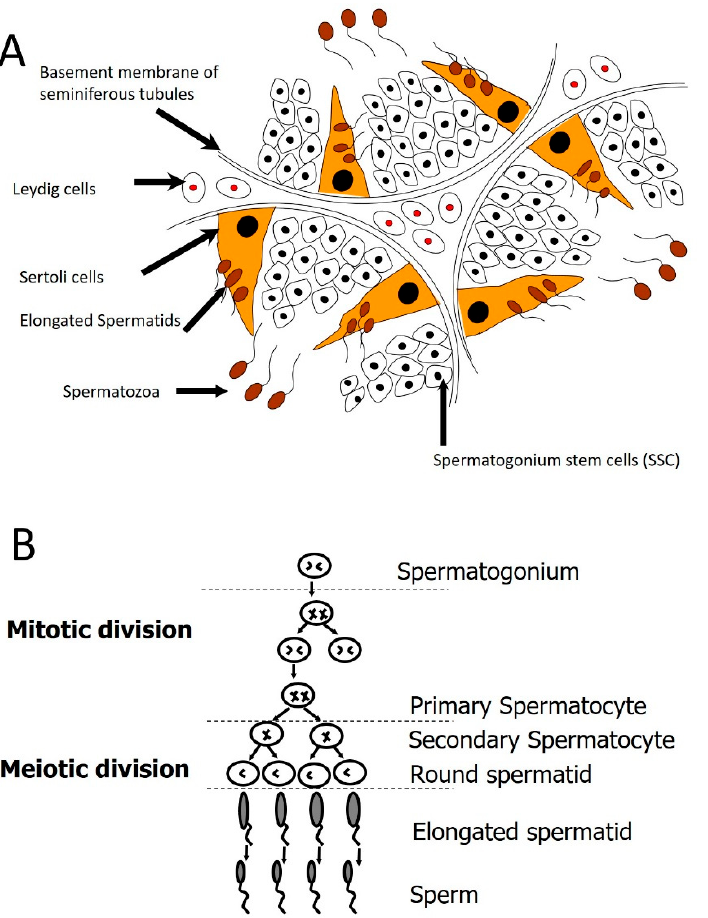
Figure 1. The process of spermatogenesis. ( A ) A cross-section in the testis, showing the process of spermatogenesis occurring in the seminiferous tubules with the aid of Sertoli cells. ( B ) After puberty, spermatogonial stem cells proceed into infinite mitotic and meiotic divisions resulting in millions of spermatozoa [97].